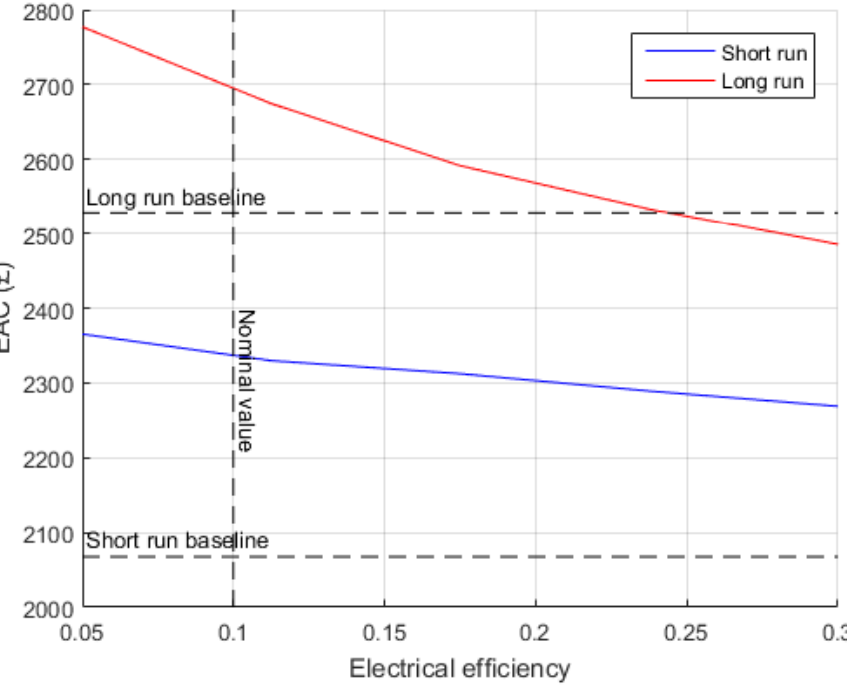
Figure 17 . Influence of Stirling engine design on economic performance.